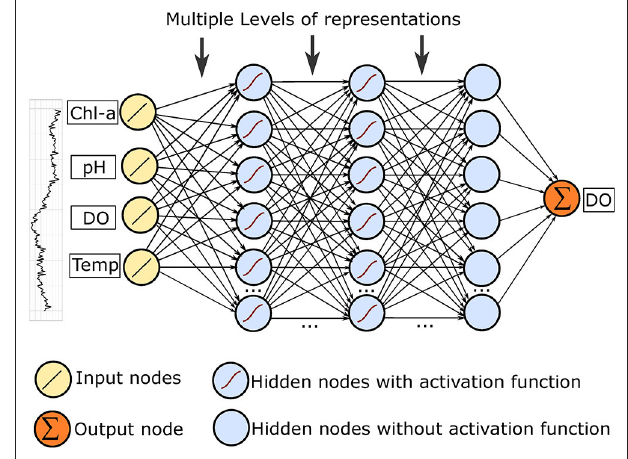
FIGURE 4 | MANN for predicting